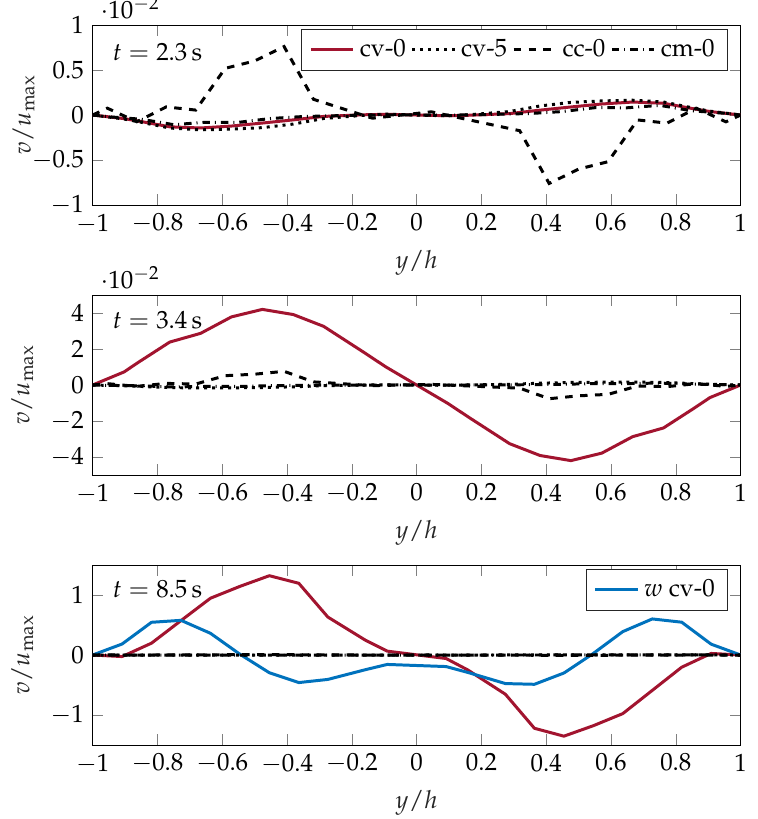
Figure 13. Spurious transverse velocity oscillations with temporally increasing amplitude for cv-0 = 1.98317 (Re = 205.04). with ˜ ω c h , b 2